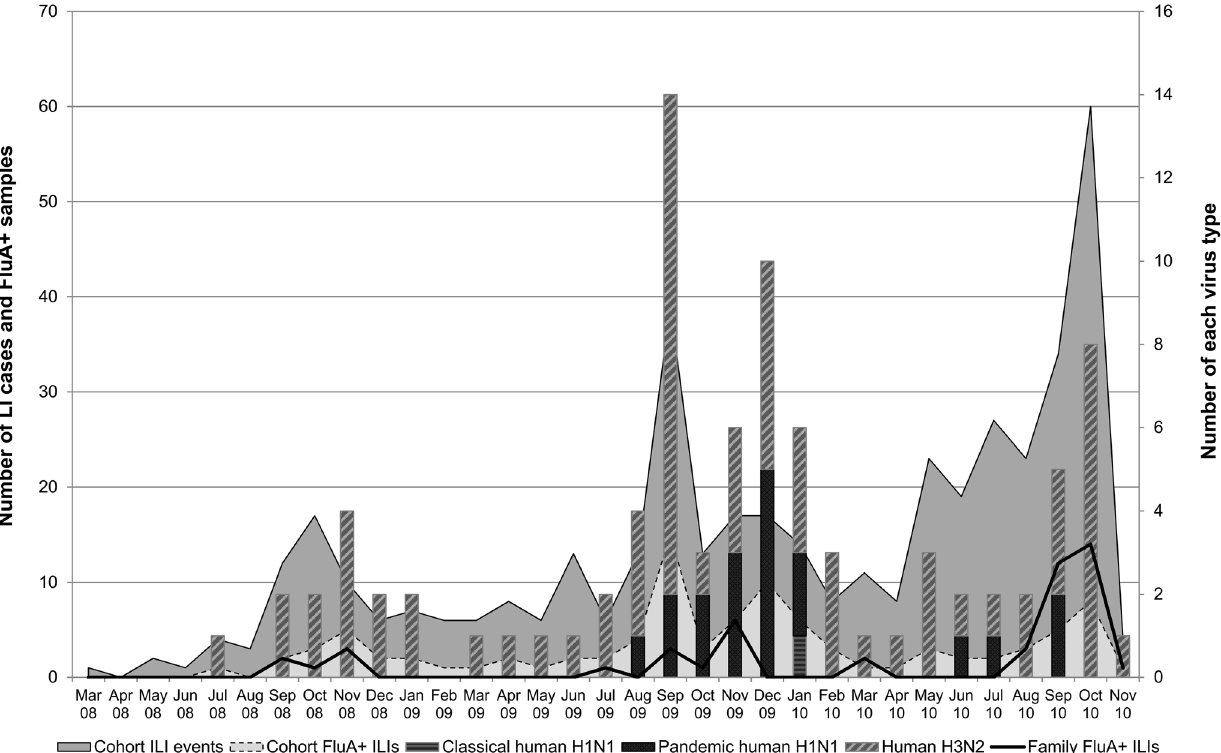
Figure 1. Reported influenza-like illnesses with real-time RT-PCR results of respiratory swabs collected from study cohort members and their family contacts at time of illness; June 2008 - November 2010; Kampong Cham,